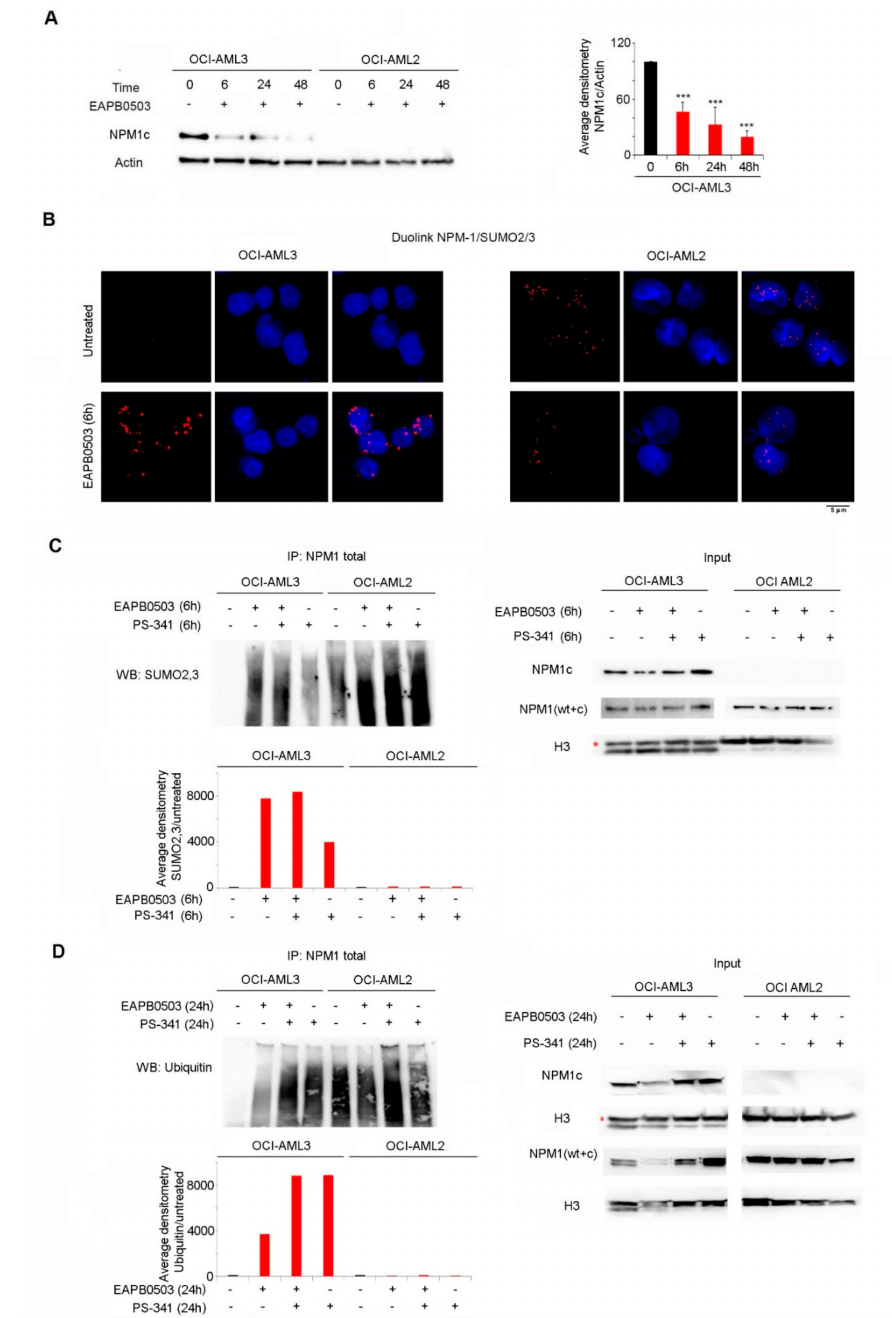
Figure 3. NPM1c expressing cells exhibit low basal levels of SUMOylation, and EAPB0503 restores NPM1c post-translational modifications triggering its proteasomal degradation. ( A ) Western blot analysis of NPM1c and Actin in OCI-AML3 and OCI-AML2 cells treated with EAPB0503 for 6, 24 and 48 h. Histogram represents the average densitometry of NPM1c/Actin in OCI-AML3 cells in three independent experiments. ( B ) Endogenous interactions detected by Duolink between NPM1 ( wt +